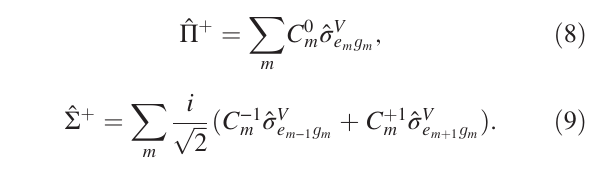
FIG. 2. Atomic bases and quantization axes. The panels exhibit some properties for different choices of atomic basis: (a) q ¼ V , (b) q ¼ H , and (c) q ¼ k . Each panel shows (i) the frame of reference f ˆ x photon-polarization decomposition that we use for each choice of atomic basis, and (iii) a pictorial representation of the dipole operators associated with each of these polarizations when written in the q atomic basis. Specifically, each dipole operator is a (weighted) sum over all ˆ σ q αβ operators for which the pair of states j α i Eqs. (8) and (9) and the operators in panel (c) to Eqs. (10) and